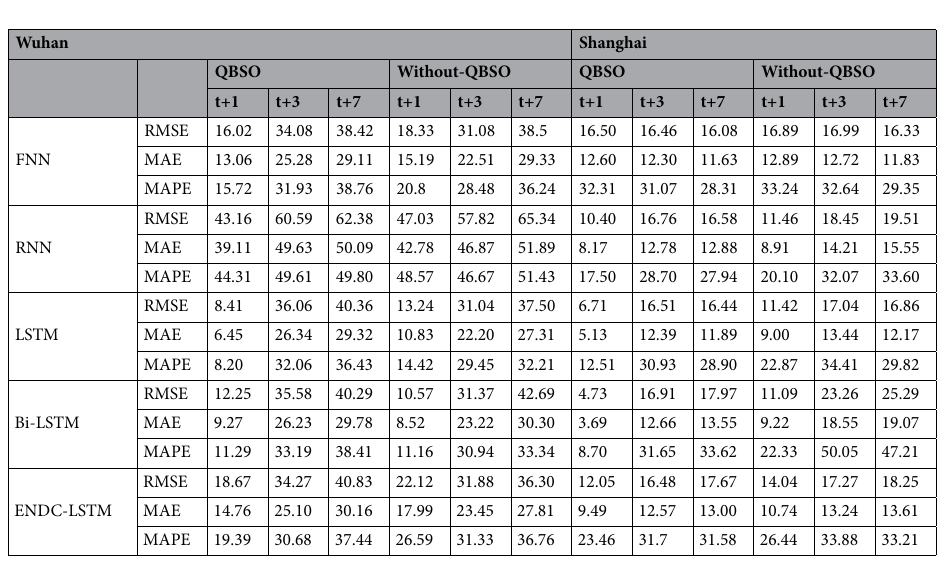
Table 8. The results of QBSO on